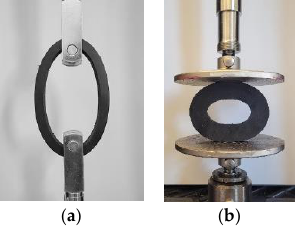
Figure 5. Experimental setups for material parameter determination: ( a ) O-ring tension and ( b ) O-ring compression test.